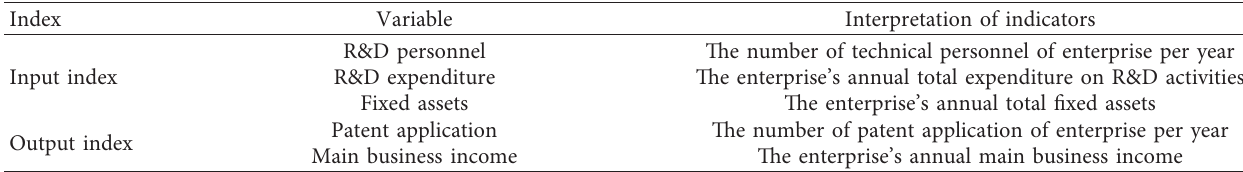
Table 1: Brief description of input and output